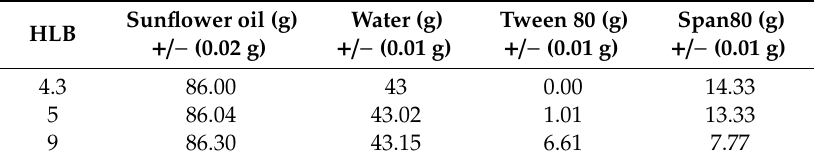
Table 4. Mass of substances required for 150 mL emulsions with di ff erent hydrophilic-lipophilic balances